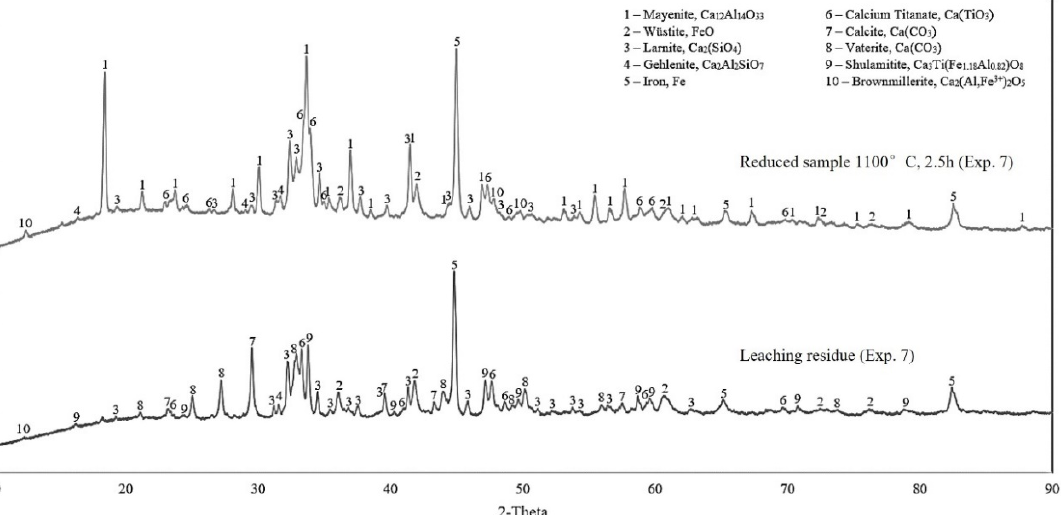
Figure 7. The XRD spectrums of leaching residue of the reduced sample 7 in comparison with the solid before leaching.